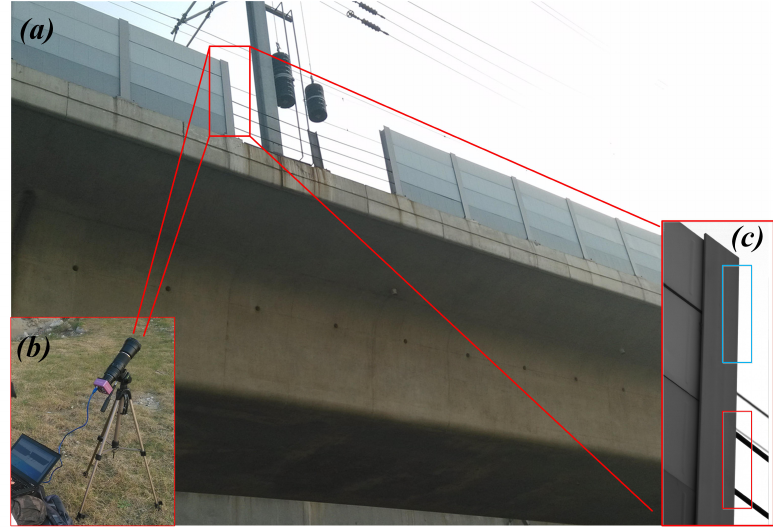
Figure 8. Noise barrier experiment setups: ( a ) the experiment environment; ( b ) experimental setup; ( c ) image captured by the high-speed camera and selected analysis areas.